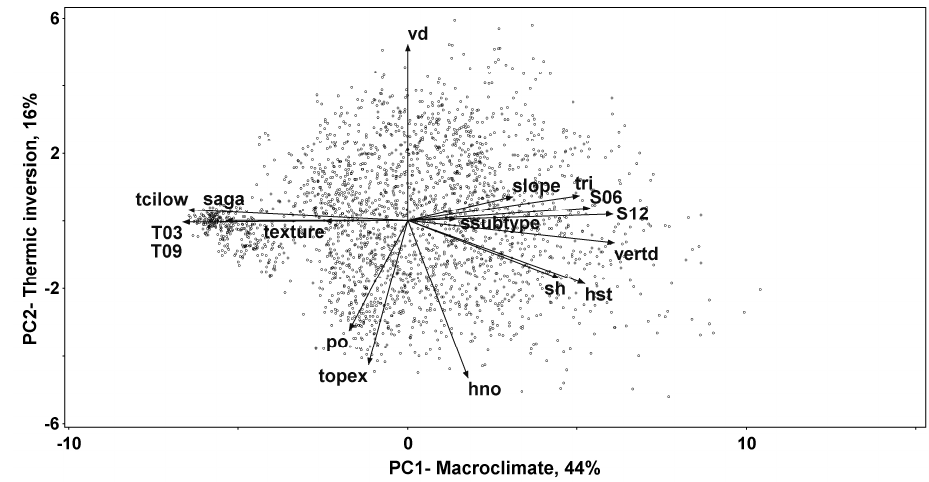
Figure 3. A biplot of sample plots and influential environment factors with significant gradients in the PCA ordination for the Carpaticum phytogeographic region. See Table 1 for the factors’